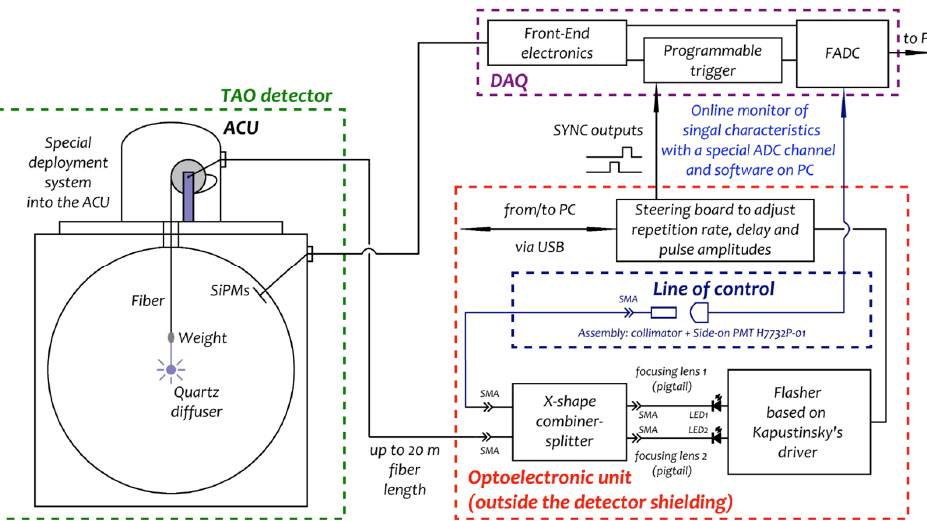
Figure 4. Simplified schematics of the UV LED calibration system. The dashed boxes show structural parts of the experimental setup namely the detector (green), the DAQ electronics (purple), and the optoelectronic unit (red) of the UV LED subsystem. The latter generates light pulses which are transferred to the detector target via fiber optics. Simultaneously, the DAQ is triggered from the steering board of the LED subsystem. Subsequently, the ADC digitizes also the signals from the control line. Figure taken from [10].